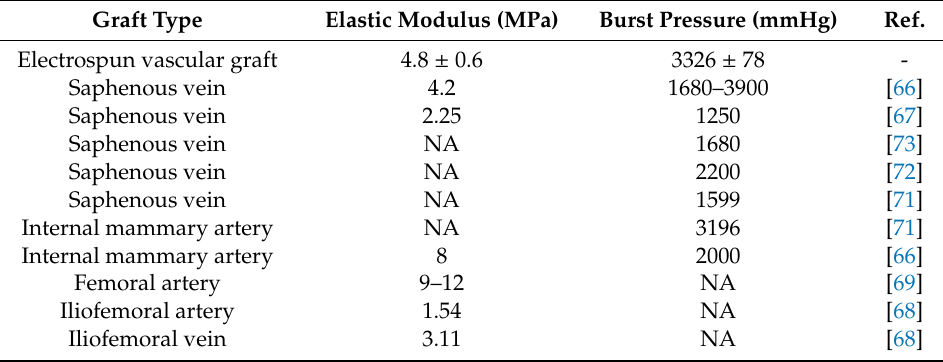
Table 2. Mechanical properties of the electrospun constructs and native blood